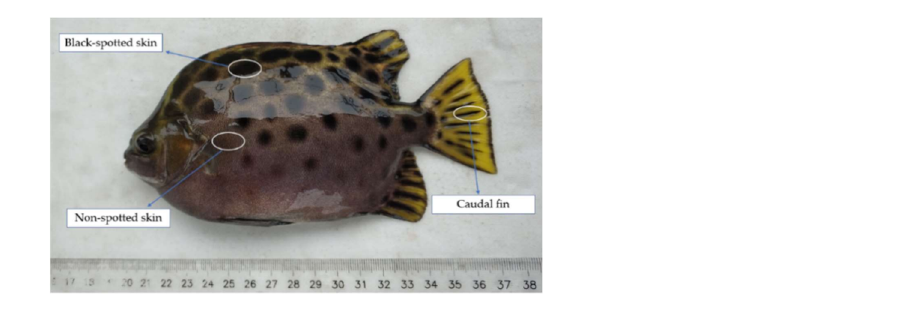
Figure 1. Sampling distribution of different color parts of S. argus (black-spotted skin; nonspotted skin; caudal